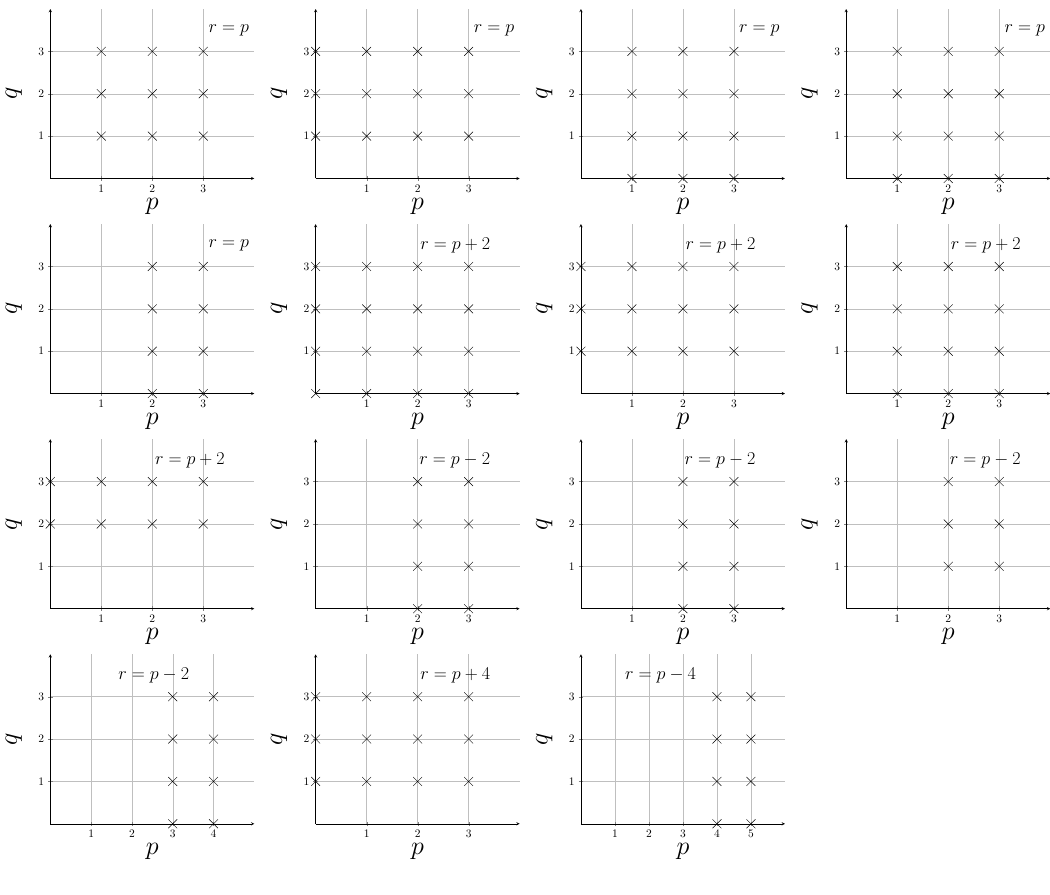
Figure 9. Two-form